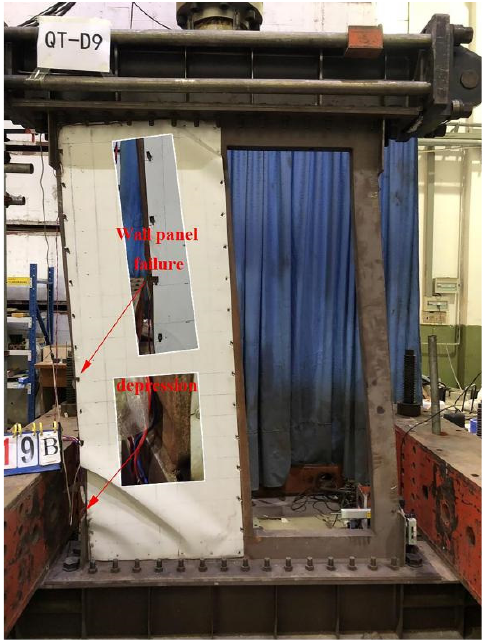
Figure 9. Failure image of QT − D9.